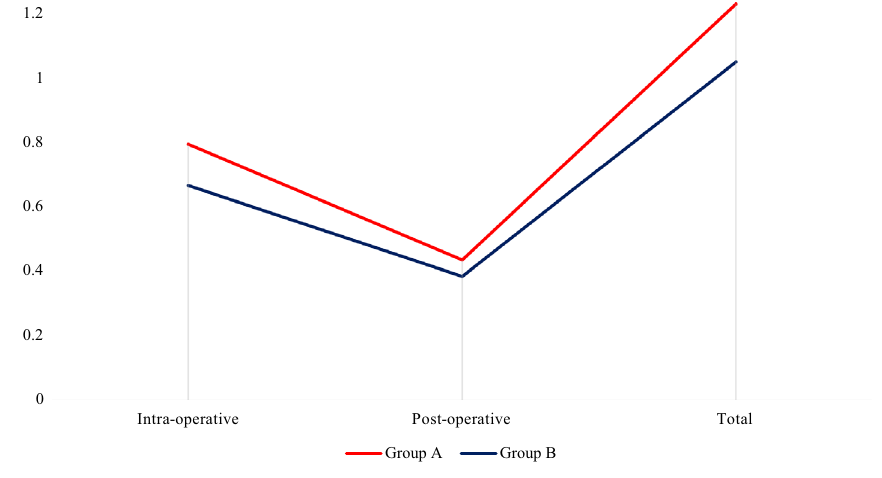
Figure 1. Average blood use in adult scoliosis surgery.